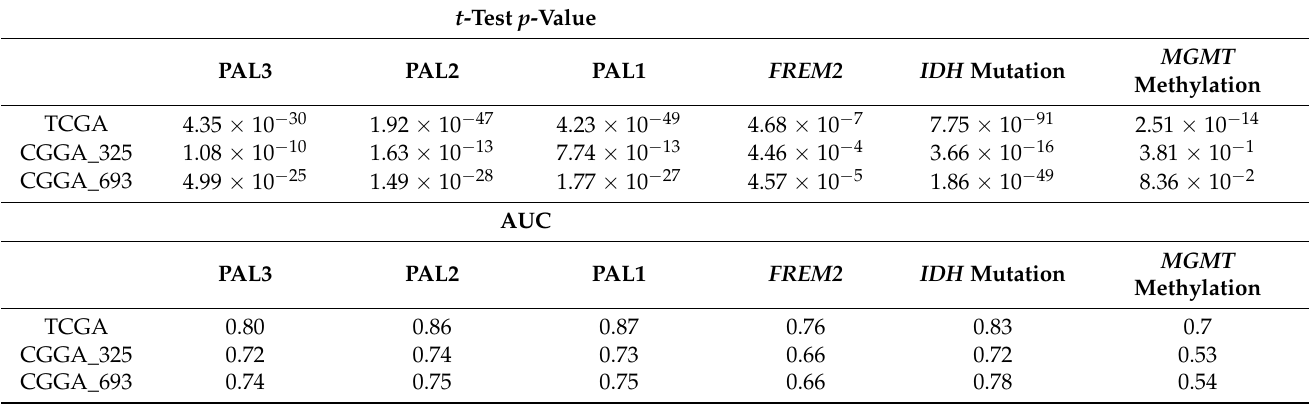
Table 1. Performance of FREM2 expression and FREM2 pathway activation for discrimination of LGG and GBM tumor samples. t -Test p